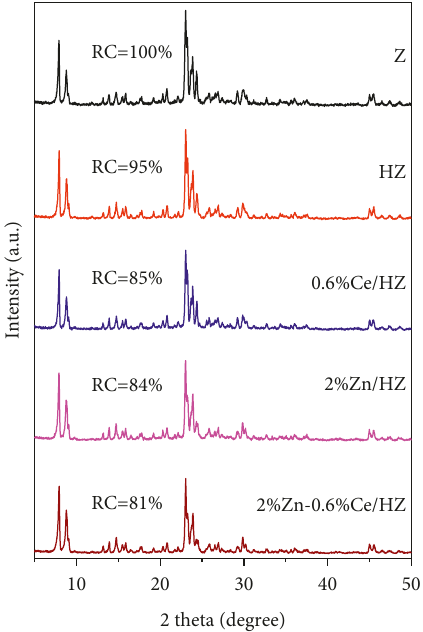
Figure 2: XRD patterns of modified ZSM-5 zeolites (RC represents relative crystallinity).